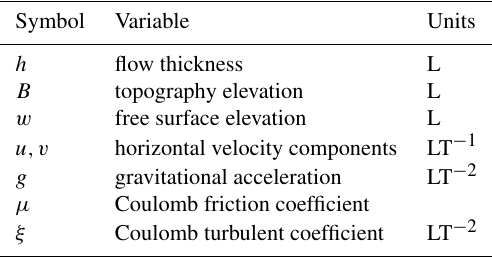
Table 1. List of model variables with notation and